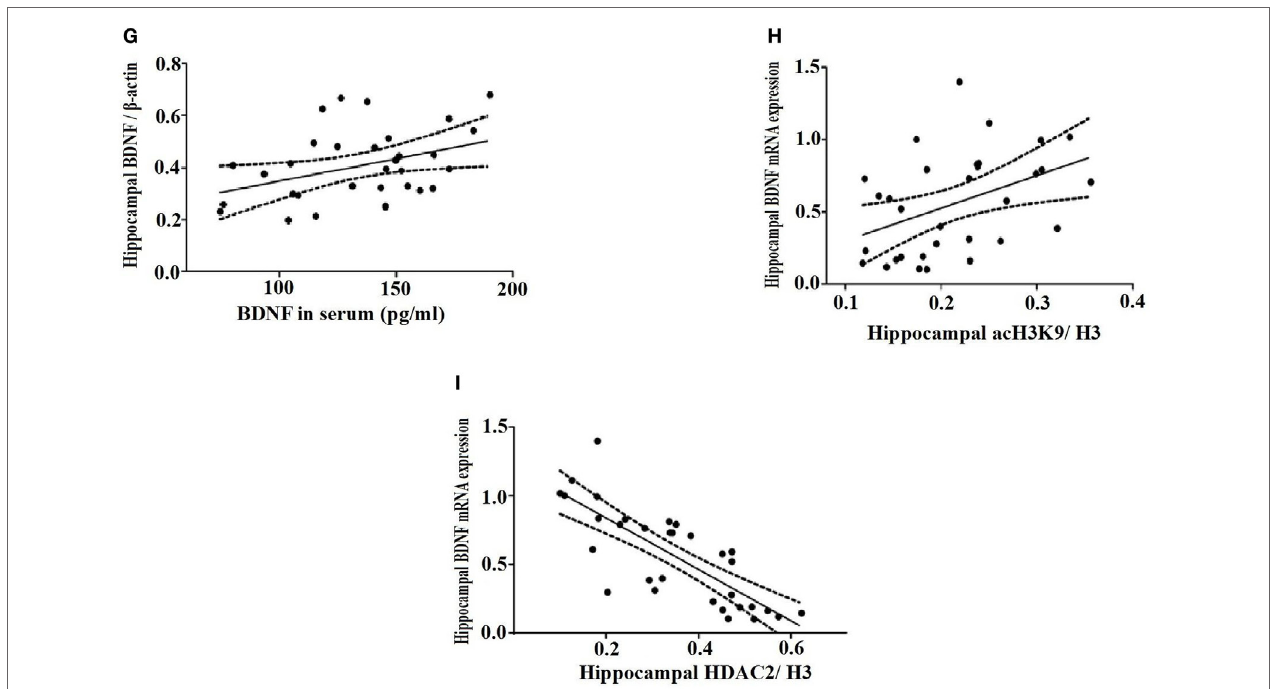
FigUre 4 | Differences showing the effects of stress/antidepressant treatments on the expression of DNA methylation and histone modifications levels of BDNF in depression rats induced by chronic unpredicted mild stress. Acu, acupuncture group; FLX, fluoxetine group; BDNF, brain-derived neurotrophic factor; RT-PCR, real-time reverse transcription-polymerase chain reaction; MS-PCR, methylation-specific polymerase chain reaction; acH3K9, acetylation levels of Histone 3 at Lysine 9; HDAC2, histone deacetylase 2. Differences were assessed with one-way analysis of variance with Fisher’s least significant difference (LSD) procedure. Results were presented as the mean ± SD (a) Enzyme-linked immunosorbent assay analysis of BDNF expression in serum of each group ( n = 8). ★★ P < 0.01 compared with the control group; ▲▲ P < 0.01 compared with the model group; ⬩ P < 0.05 compared with the acupuncture group. (B) Western blot (WB) analysis of BDNF expression in hippocampus of each group ( n = 8). ★★ P < 0.01 compared with the control group; ▲▲ P < 0.01 compared with the model group. (c) Expression of mRNA level of BDNF in the hippocampus of each group ( n = 8). ★★ P < 0.01 compared with the control group; ▲▲ P < 0.01 compared with the model group; ⬩⬩ P < 0.01 compared with the acupuncture group. (D) The DNA methylation level of hippocampal BDNF promoter I at relative CpG sites among each group ( n = 6), as detected by MS-PCR. The 12 CpG sites situated in the BDNF promoter I are as follows: CpG2, CpG4, CpG 5, CpG6, CpG10, CpG11, CpG12, CpG13, CpG14, CpG15, CpG16, CpG18, and CpG24. (e) The expression level of acH3K9 in hippocampus among each group ( n = 8), as detected by WB. ★ P < 0.05 compared with the control group. (F) The expression level of HDAC2 in hippocampus among each group ( n = 8), as detected by WB. ★★ P < 0.01 compared with the control group; ▲▲ P < 0.01 compared with the model group. (g) The correlation analysis between the expression level of BDNF in serum and hippocampus. Linear regression analysis: